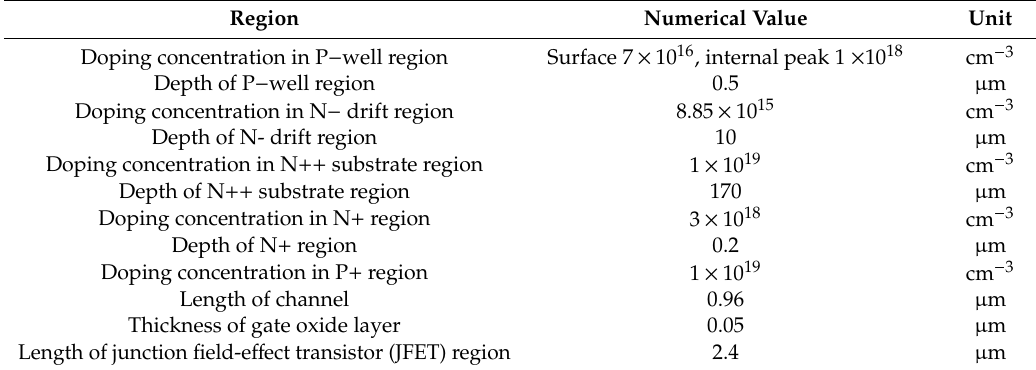
Table 1. Structure parameters of the metal-oxide-semiconductor field-e ff ect transistor (MOSFET) shown in Figure 1.